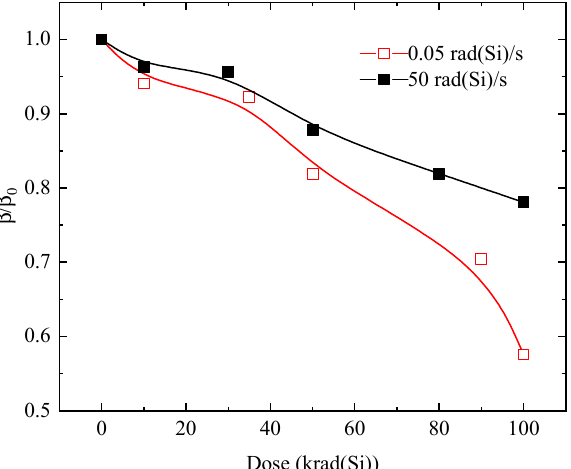
Figure 3. The excess base current of DPSA BJTs irradiated at a dose rate of 50 rad (Si)/s and 0.05 rad (Si) / s for PNP. (Si)/s for PNP.